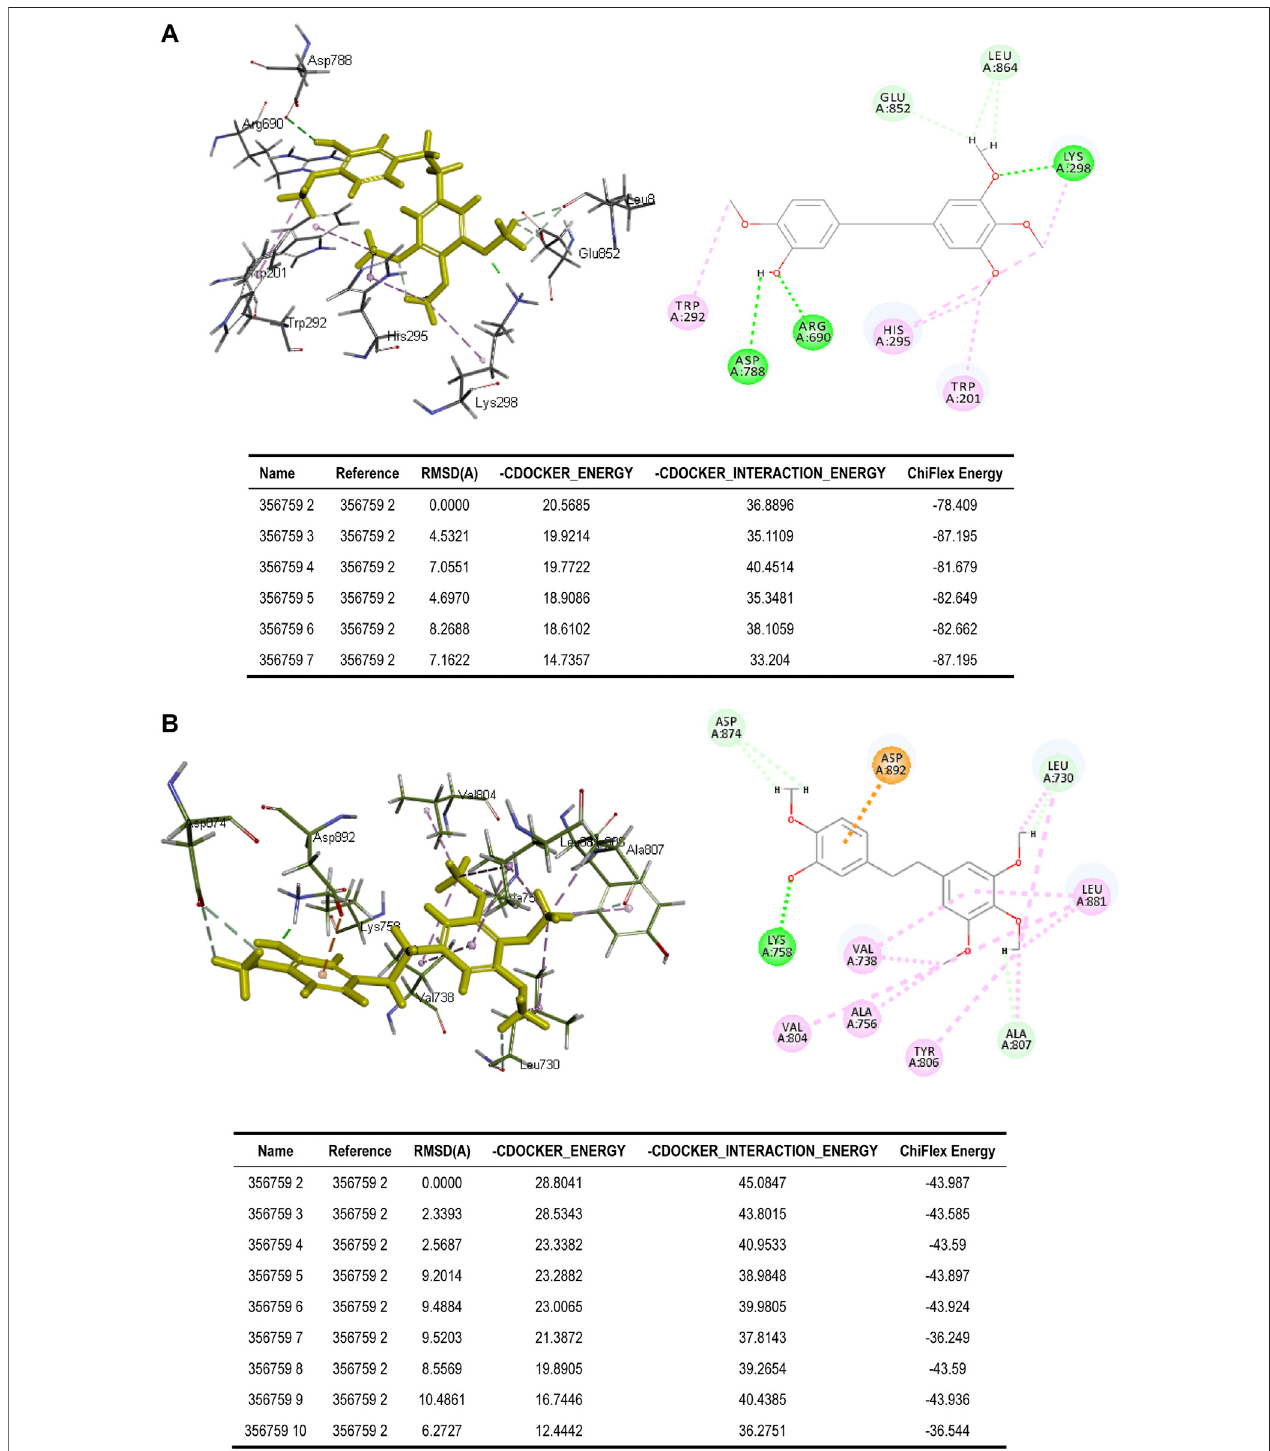
FIGURE 4 | Binding of erianin with (A) PI3K and (B) RET by molecular docking. Erianin exhibits high binding af fi nity to PI3K protein via sites of Trp292, Asp788, Arg690,His295,Trp201,Lys298,Leu864,andGlu852,andtoRETprotein via sitesofAsp874,Asp892,Lys758,Leu730,Leu881,Val738,Val804,Ala756,Tyr806,and